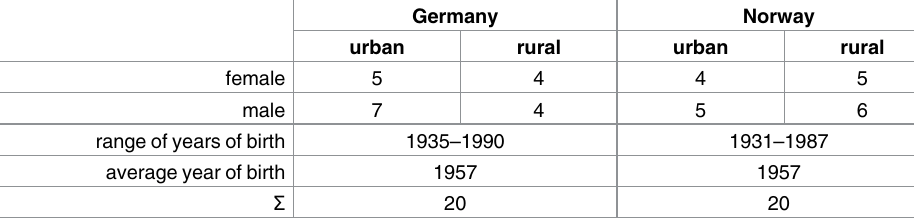
Table 2. Socio-demographic information of our sample of